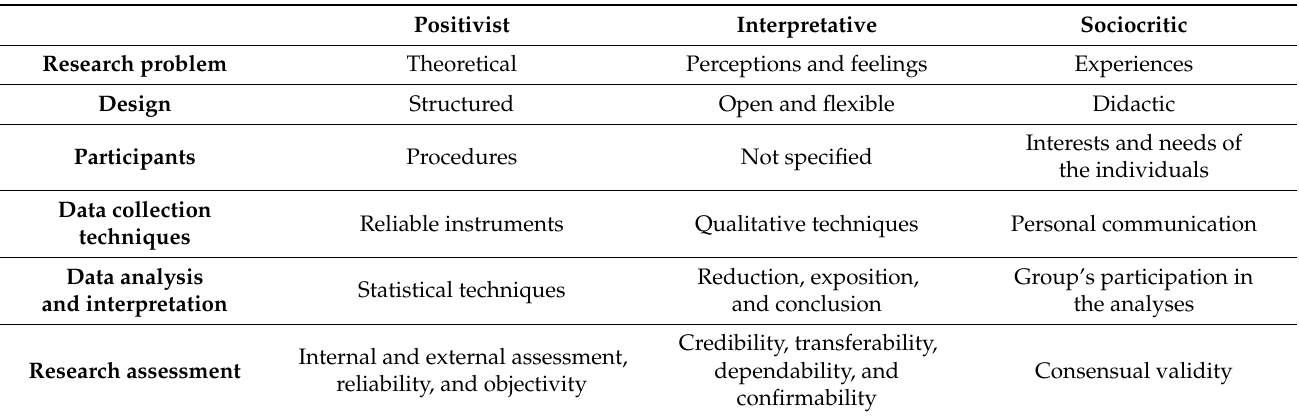
Table 1. Methodological derivations of research